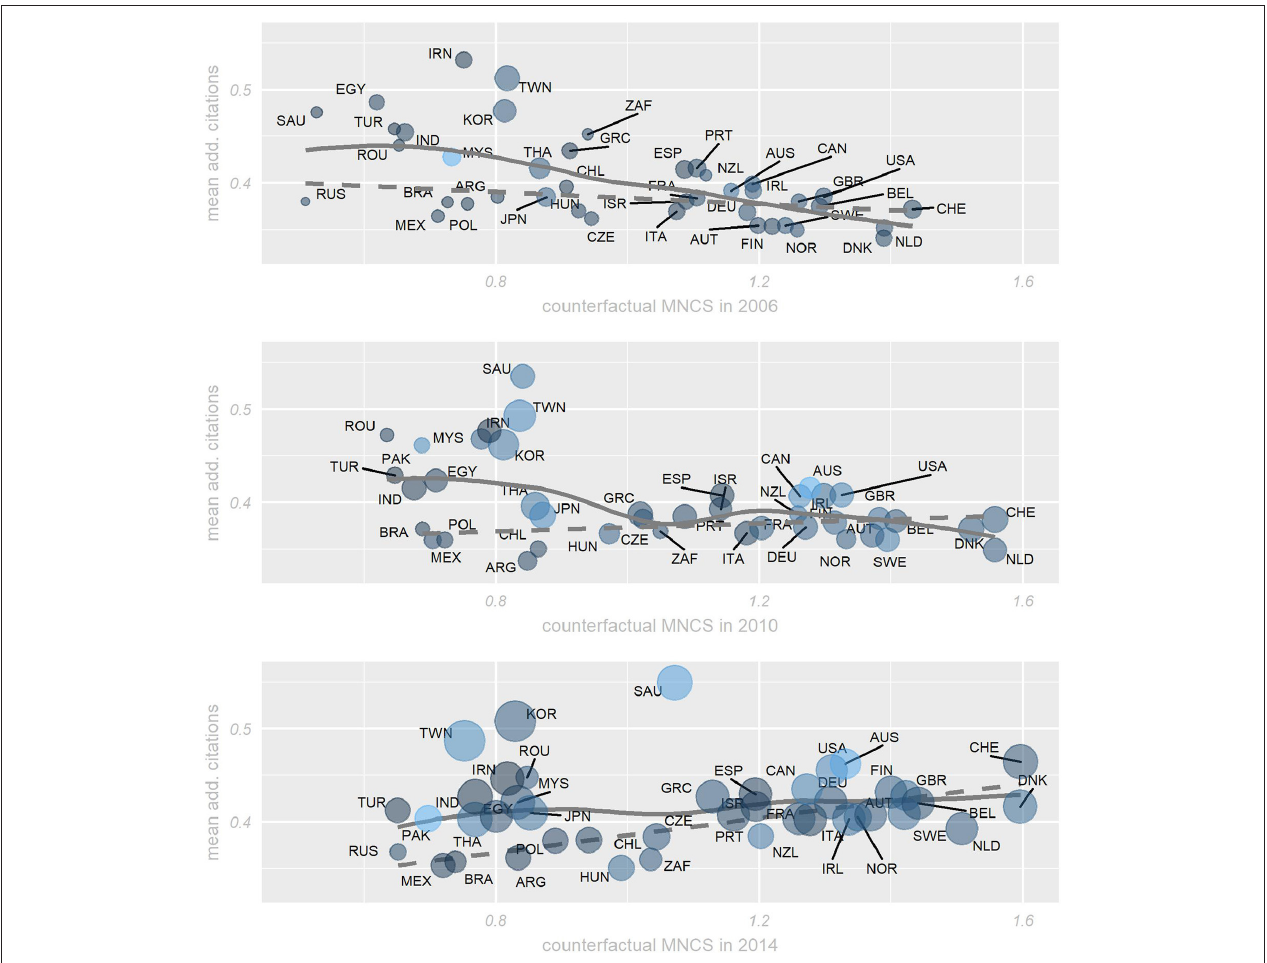
FIGURE 5 | National difference between counterfactual national impact and average, normalized, additional citations from China in 2006, 2010, and 2014 with linear correlation line for non-Asian countries and non-linear relation for all countries receiving more than 1,500 citations. Point size indicates the share of national publications becoming cited by China, while a more pale color illustrates a higher national share of co-authored papers with China. Singapore is not